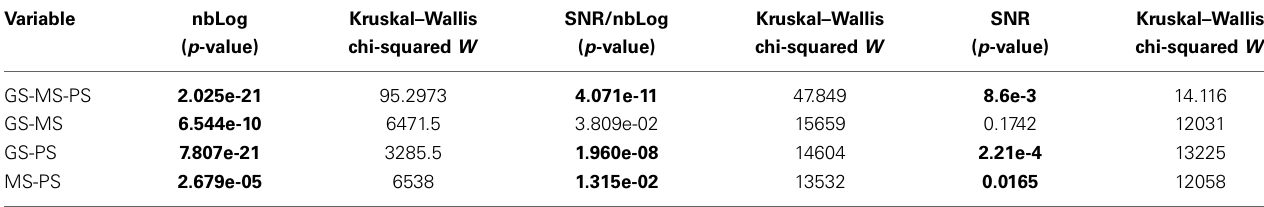
Table 2 | Test on classes nbLog, SNR/nbLog, and SNR for oblique traces. Variable